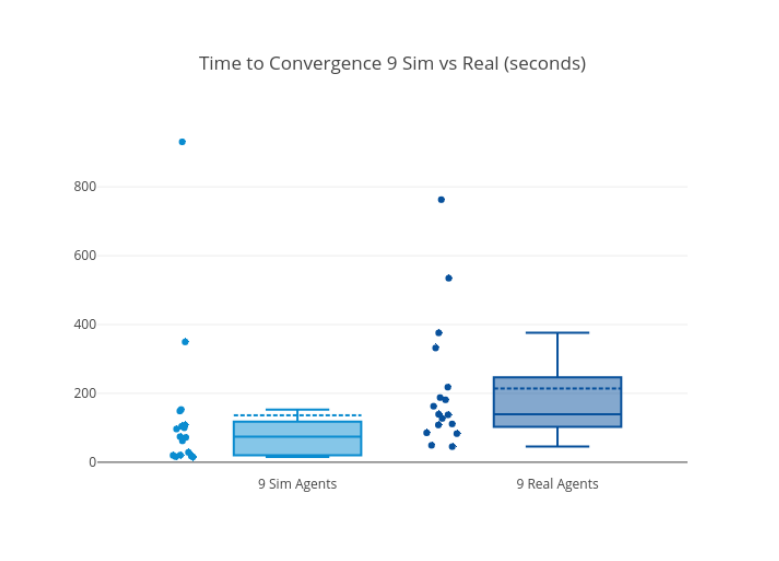
Fig. 7. This figure shows a comparison between the time the agents took to converge on the simulated configuration and the real